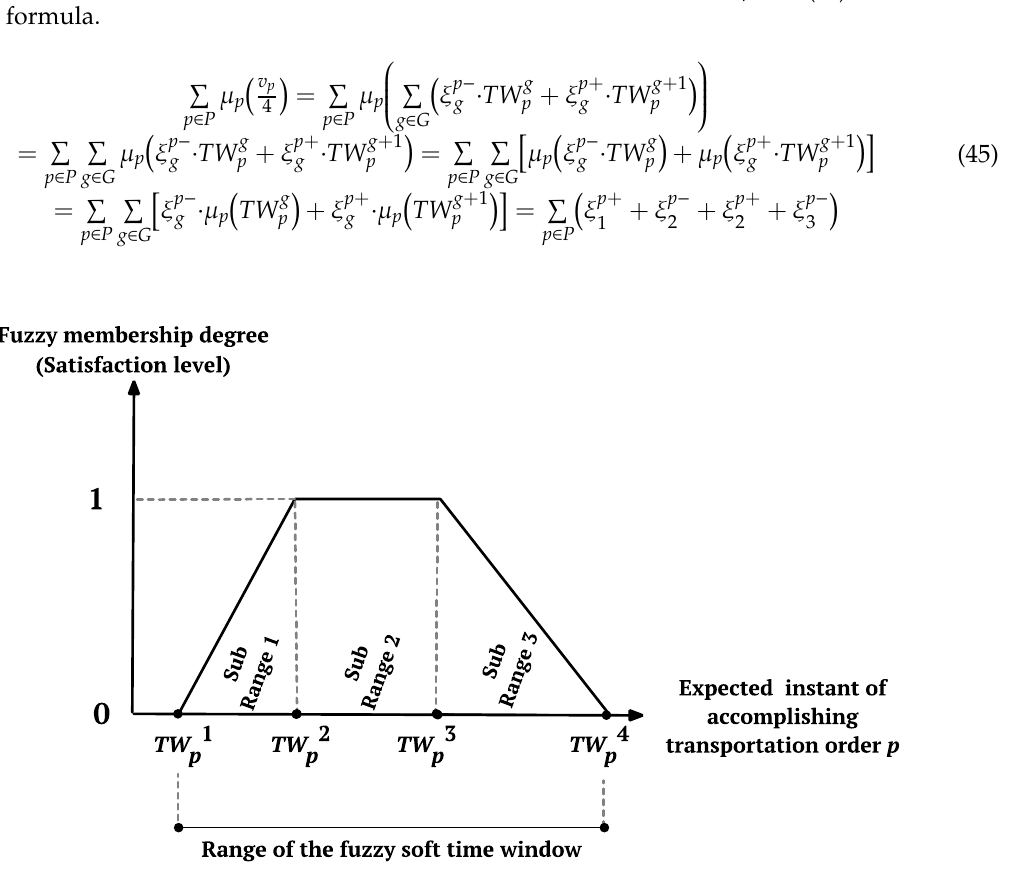
Figure 10. Sub ranges of the range of the fuzzy soft time window.